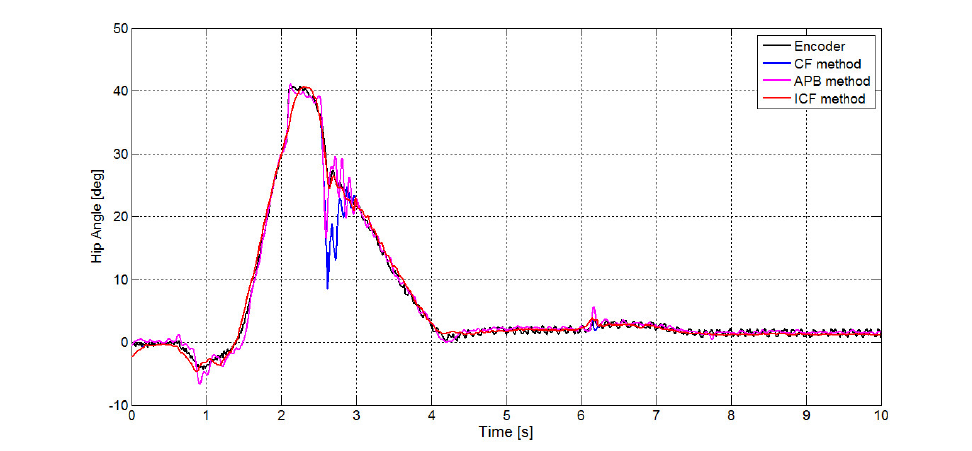
Figure 8. Comparison between the APB, CF and intelligent complementary filter (ICF) methods vs. encoder measurement: ( a ) hip angle estimation; ( b ) particulars of the comparison between estimation methods for the hip angle; ( c ) knee angle estimation; ( d ) particulars of the comparison between estimation methods for the knee